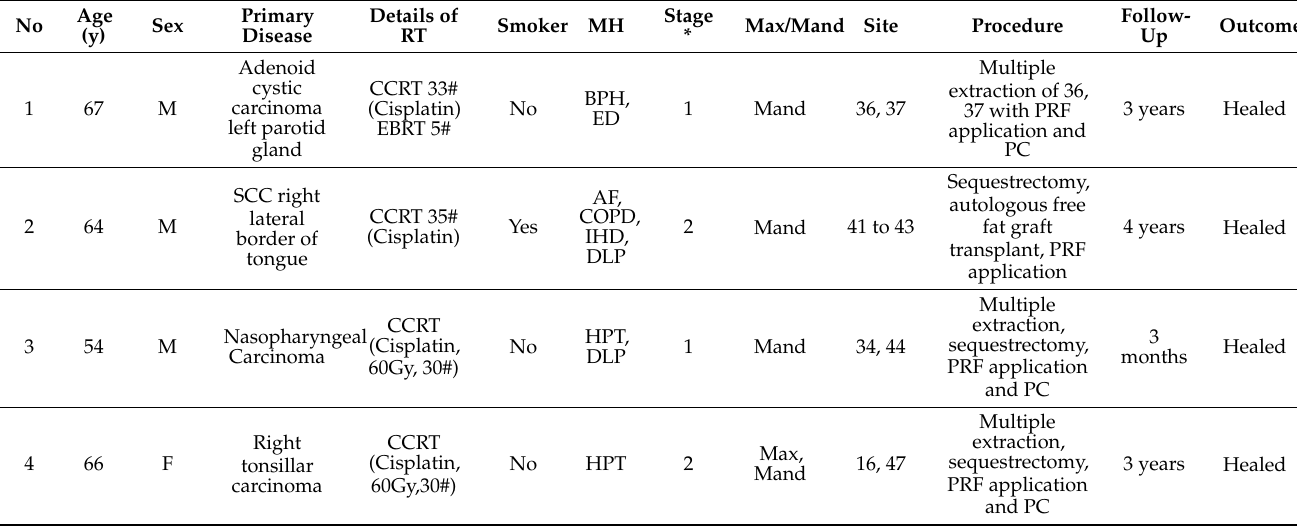
Table 2. Clinical characteristics of patients with osteoradionecrosis (ORN) treated with PRF as